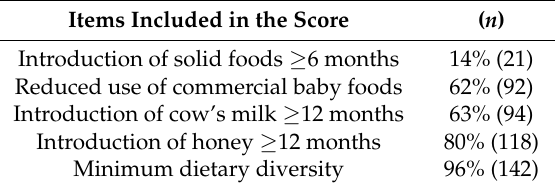
Table 2. Percentage of mothers who followed the WHO recommendations ( n = 148). Items Included in the